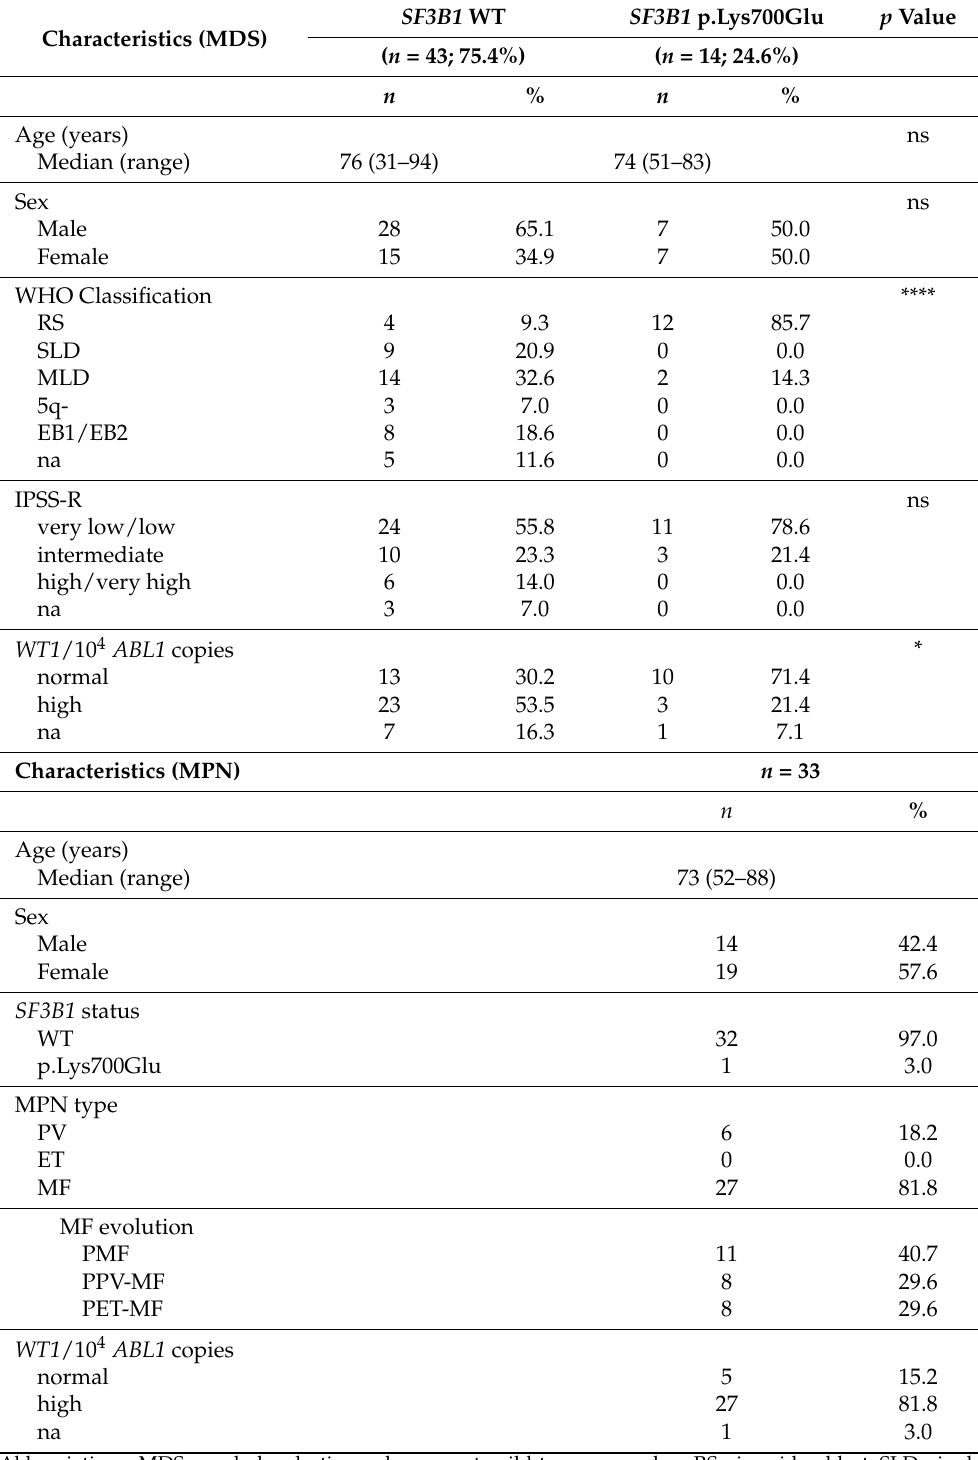
Table 2. MDS patients and MPN patients’